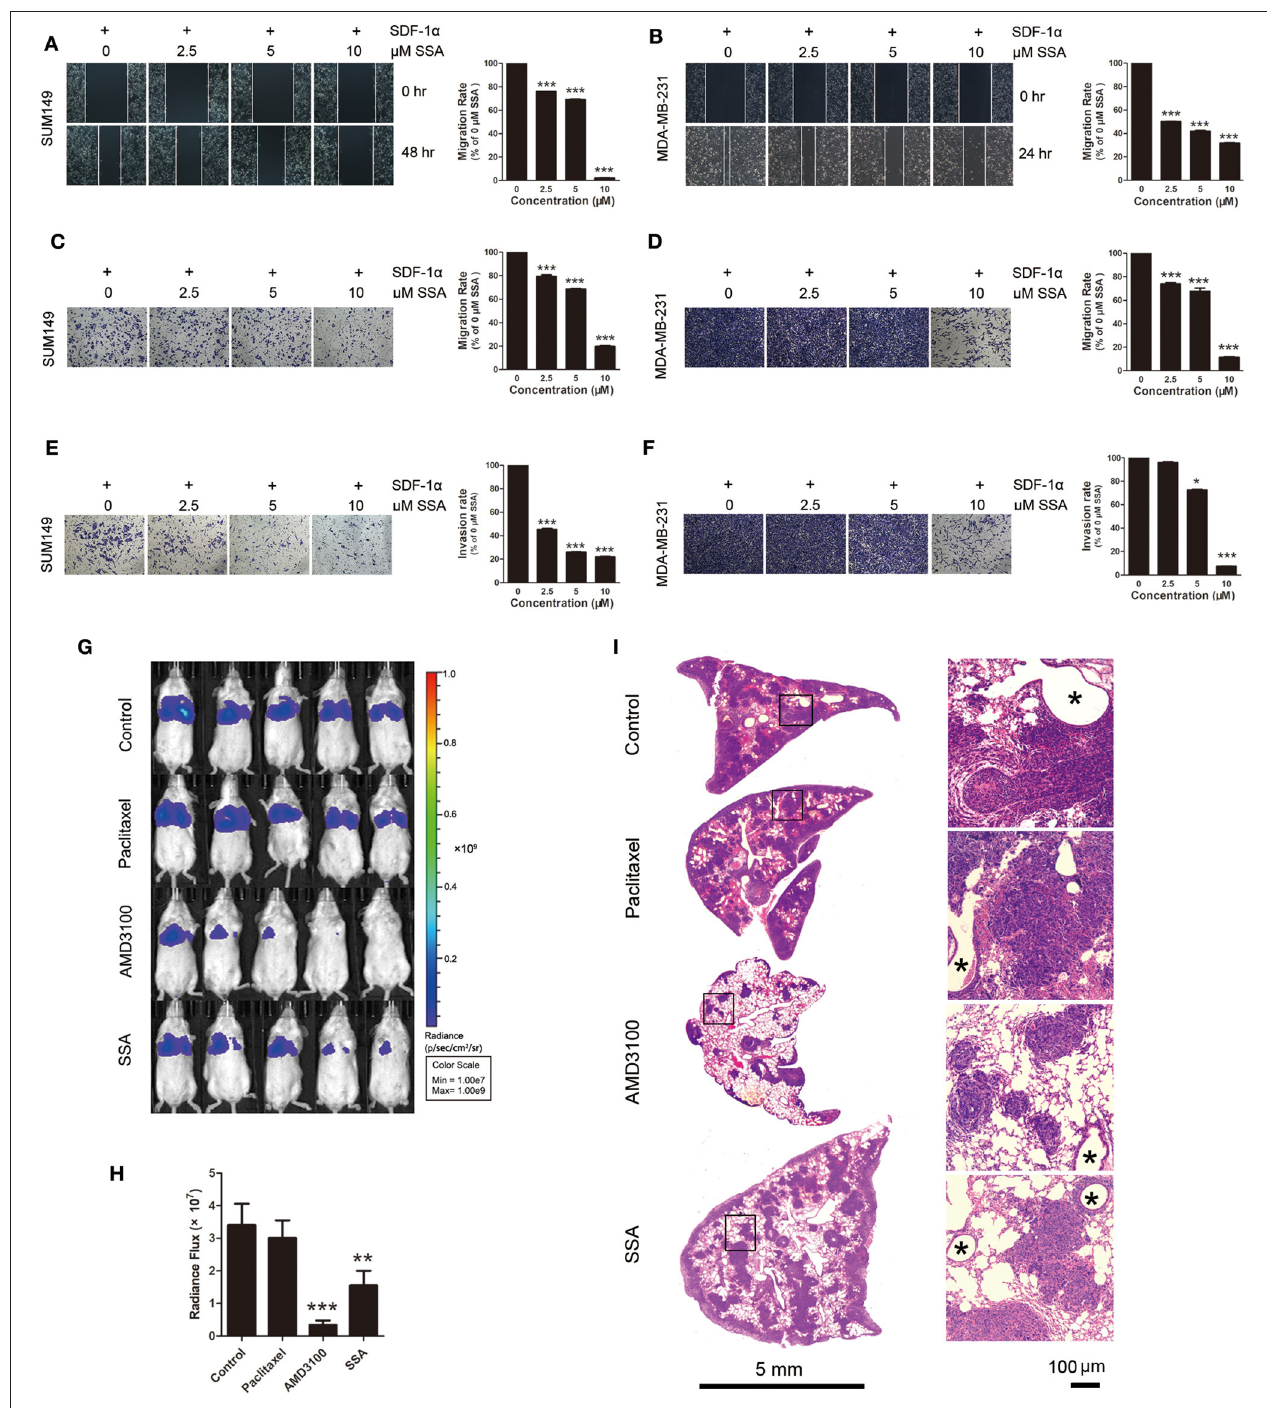
FIGURE 3 | SSA suppresses the migration and invasion of TNBC cells and the lung metastasis of 4T1-luc cells. (A,B) Photographs and quantification of wounds to SUM149 and MDA-MB/231 cells treated with SSA. (C,D) Photographs and quantification of SUM149 and MDA-MB/231 cell migration through Transwell migration chambers with 8- µ m pores and stained with 0.2% crystal violet. (E,F) Photographs and quantification of SUM149 and MDA-MB/231 cell invasion through Matrigel-coated polycarbonate membranes, with cells stained by 0.2% crystal violet. The independent experiments were performed in triplicate. * p < 0.05; *** p < 0.001 compared with 0 µ M of SSA. (G) Luciferase imaging of lung metastases at 2 weeks after injection of 4T1-luc cells and treatment with paclitaxel, AMD3100, or SSA. (H) ROI analysis of images obtained at 2 weeks was used to quantify changes in cell numbers in lungs after treatment with paclitaxel, AMD3100, or SSA. The data represent mean values ± SEM for photon flux in each group ( n = 5). ** p < 0.01, *** p < 0.001 vs. control. (I) H&E staining of lung tissue of 4T1-luc mice. The photographs in the right row are magnifications of the boxes in the left row. Asterisks indicate bronchioles in lung tissue.